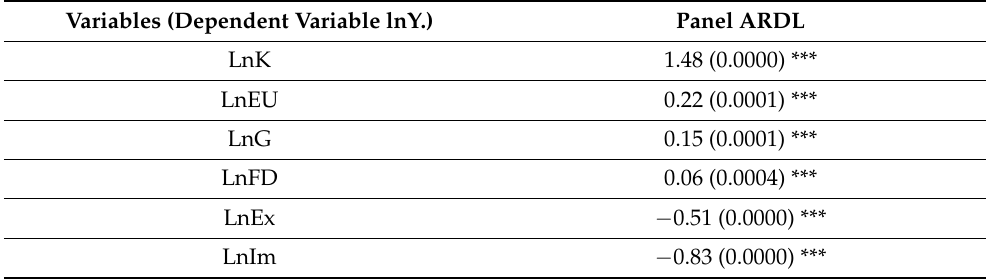
Table 6. Long-run Results from Panel ARDL. Variables (Dependent Variable